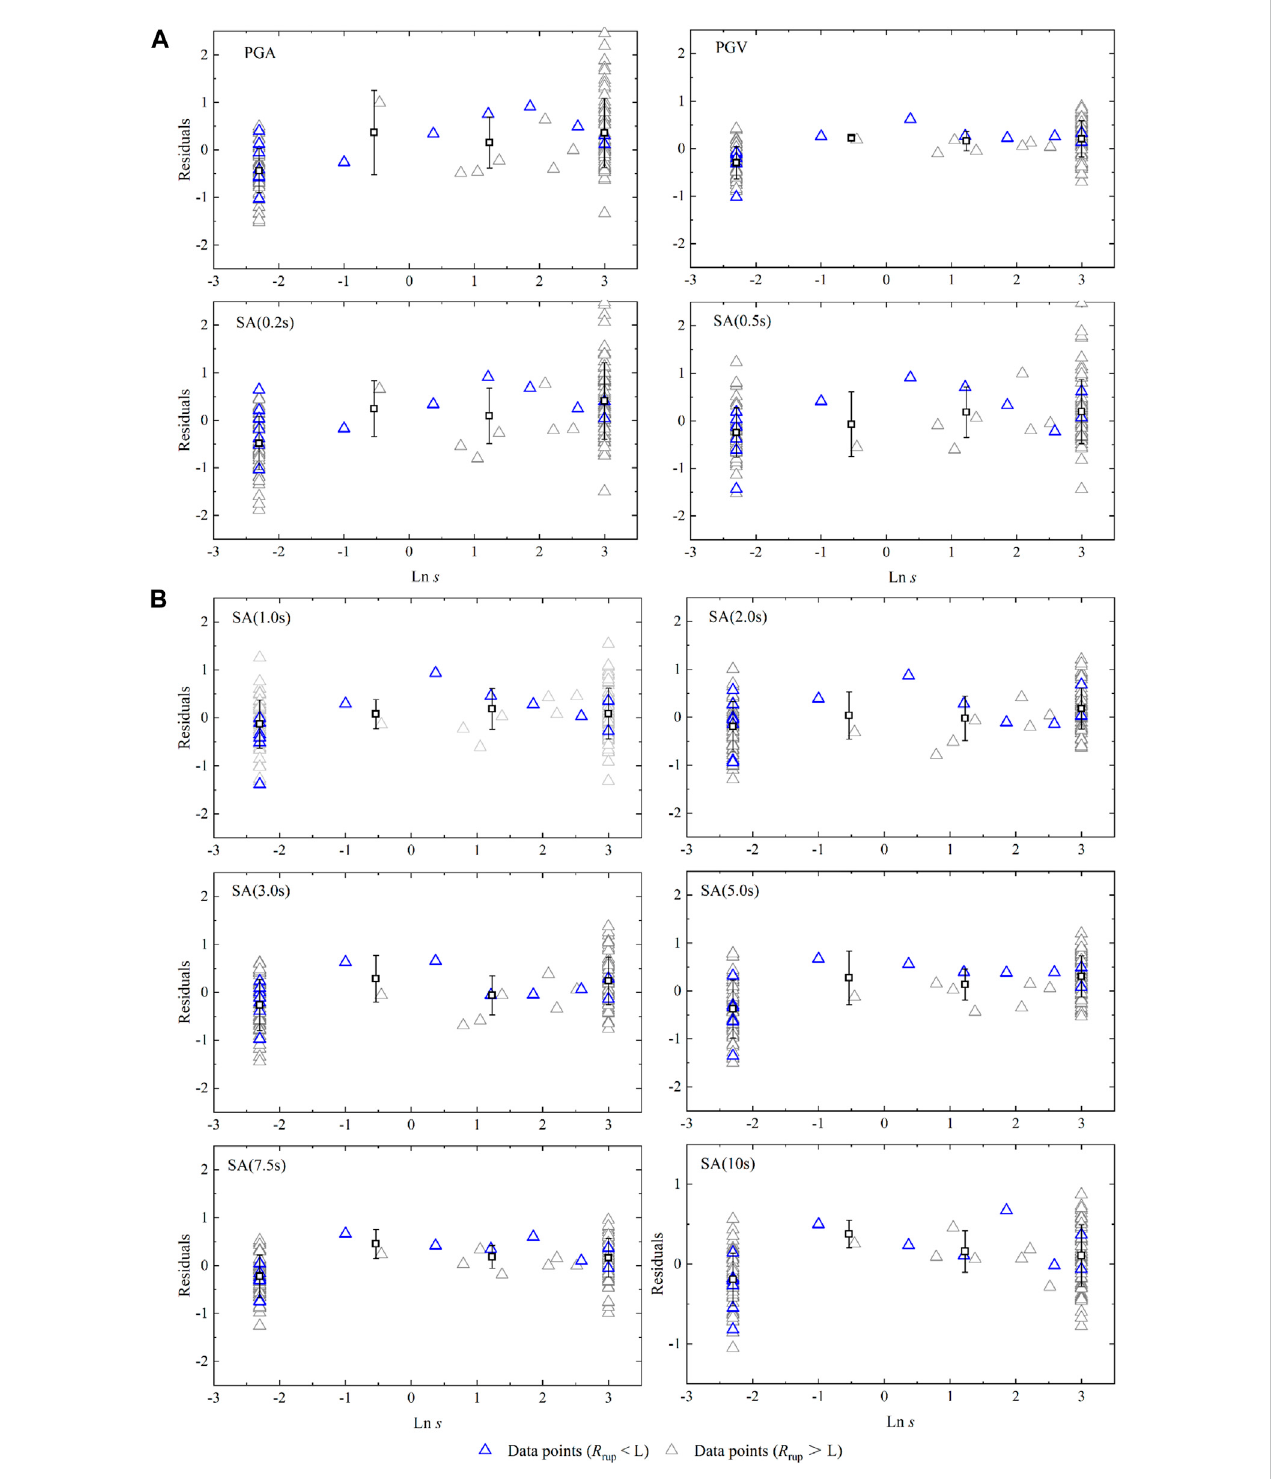
FIGURE 8 VariationinresidualswithparametersforvariousIMs (A) PGA,PGV,andshort-periodgroundmotionoflessthan1.0 s; (B) Long-periodgroundmotionof greater than 1.0 s. The data points for R rup < L and R rup > L (length of ruptured fault) are both shown in this fi gure. The data points in the backward region with θ > 90 ° are depicted as negative distances. The vertical bars represent the mean and standard deviation of the binned